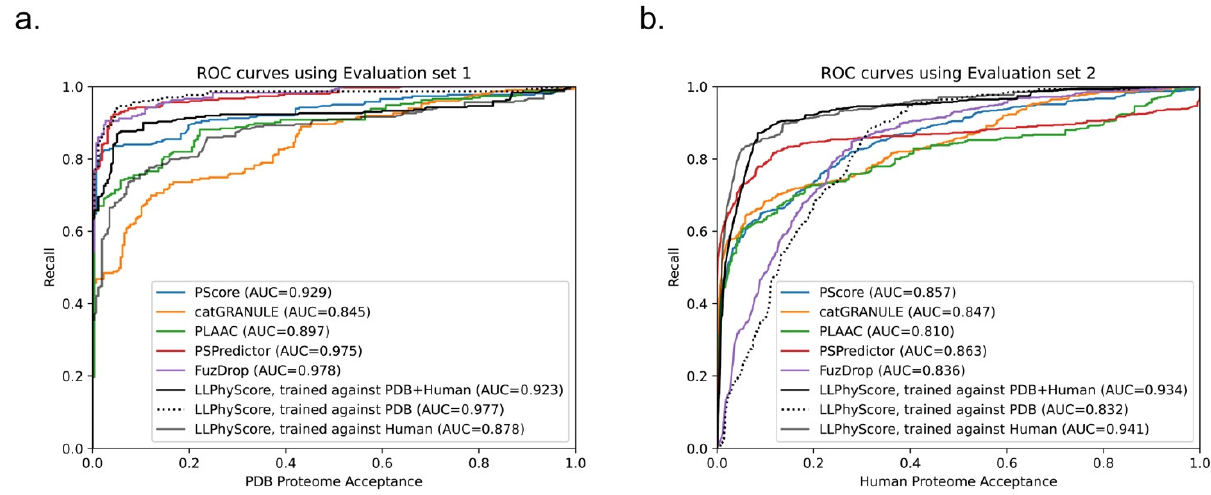
Figure 9. Comparison of LLPhyScore (three models) with other phase-separation predictors. Relationship between percent recall and total percentage of ( a ) evaluation set 1 and ( b ) evaluation set 2 accepted at the given thresholds for PScore, catGRANULE, PLAAC, PSPredictor, FuzDrop and LLPhyScore.